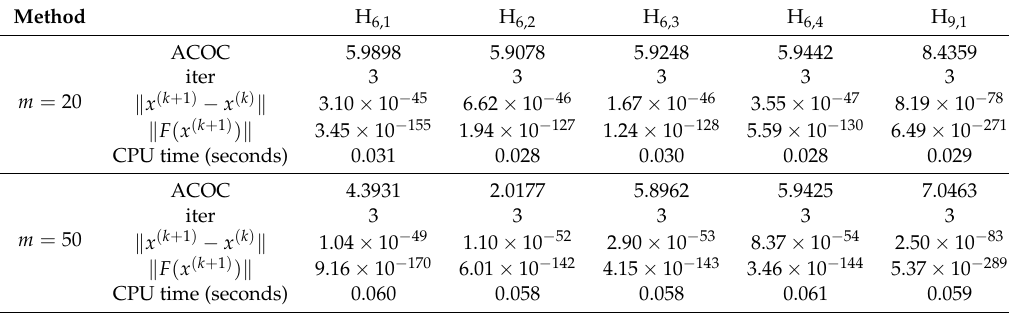
Table 2. Numerical results for Example